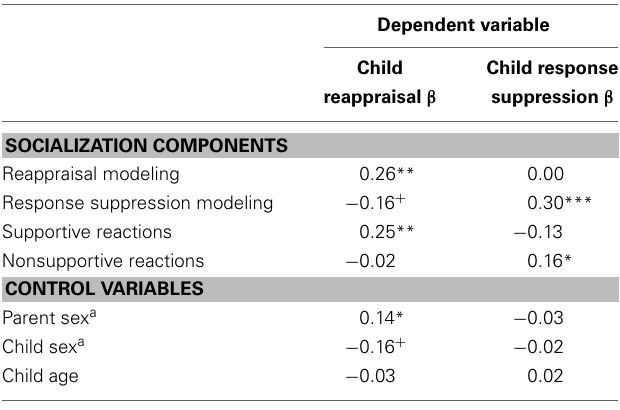
Table 4 | Direct relations of emotion socialization components with children’s emotion regulation